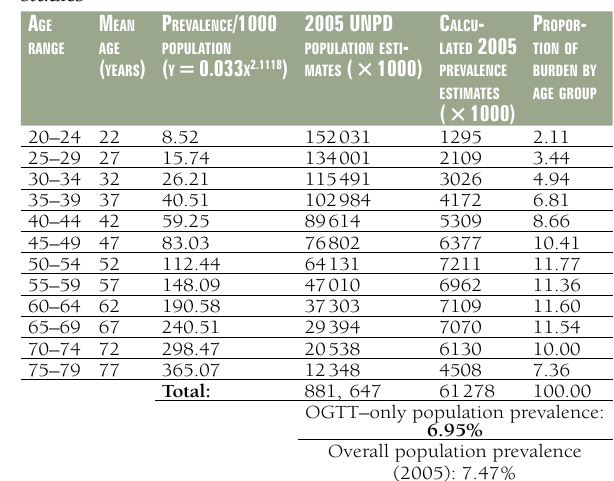
Table 18. Prevalence estimates for 2005 based on OGTT–only